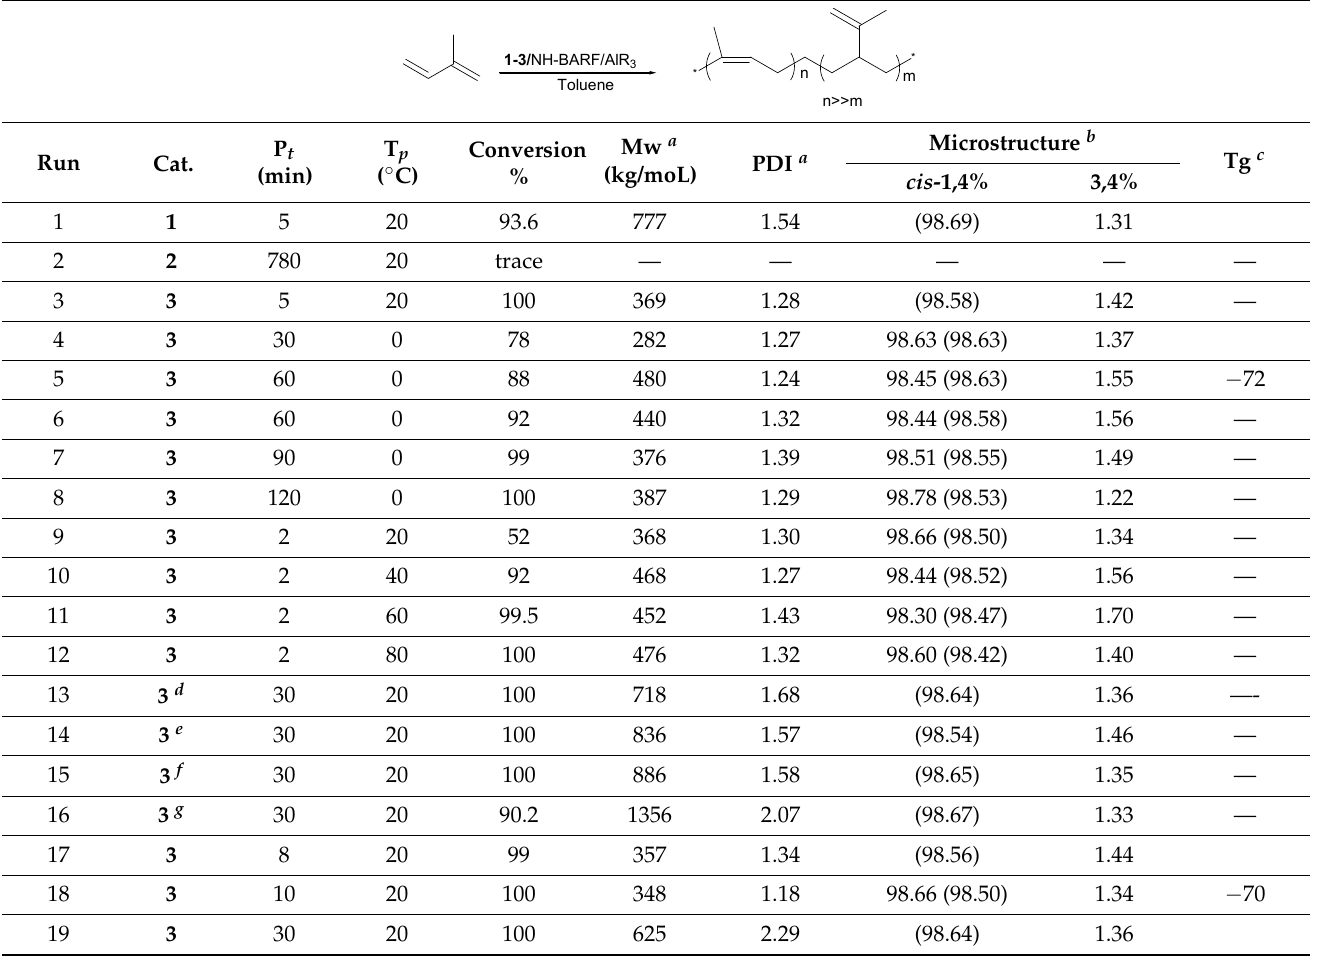
Table 1. Polymerization of isoprene (IP) with 1 , 2 , 3 and NH-BARF catalyst systems.